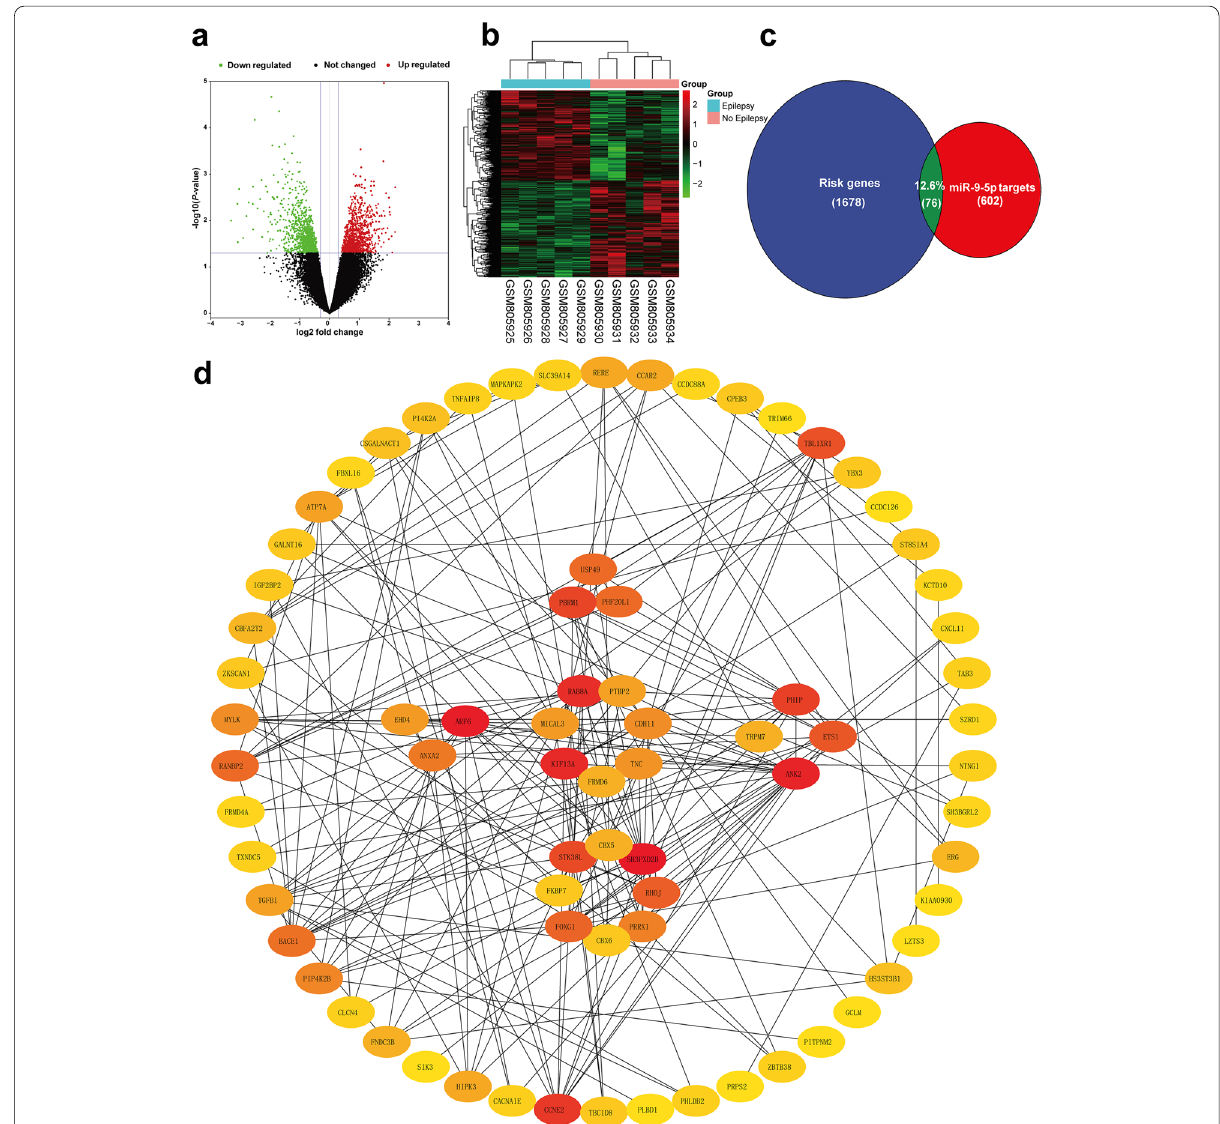
Fig. 6 Targets of hsa-miR-9-5p are associated with glioma-associated epilepsy. a Volcano plot of DEGs. b Heatmap of the DEGs. c Venn diagrams of overlap between DEGs (risk genes) and miR-9-5p targets. d Schematic diagram of PPI of targets of hsa-miR-9-5p associated with glioma-associated epilepsy. Five significant functional modules identified by MCODE were circled by other targets. For both nodes, a darker color indicates a higher MCC